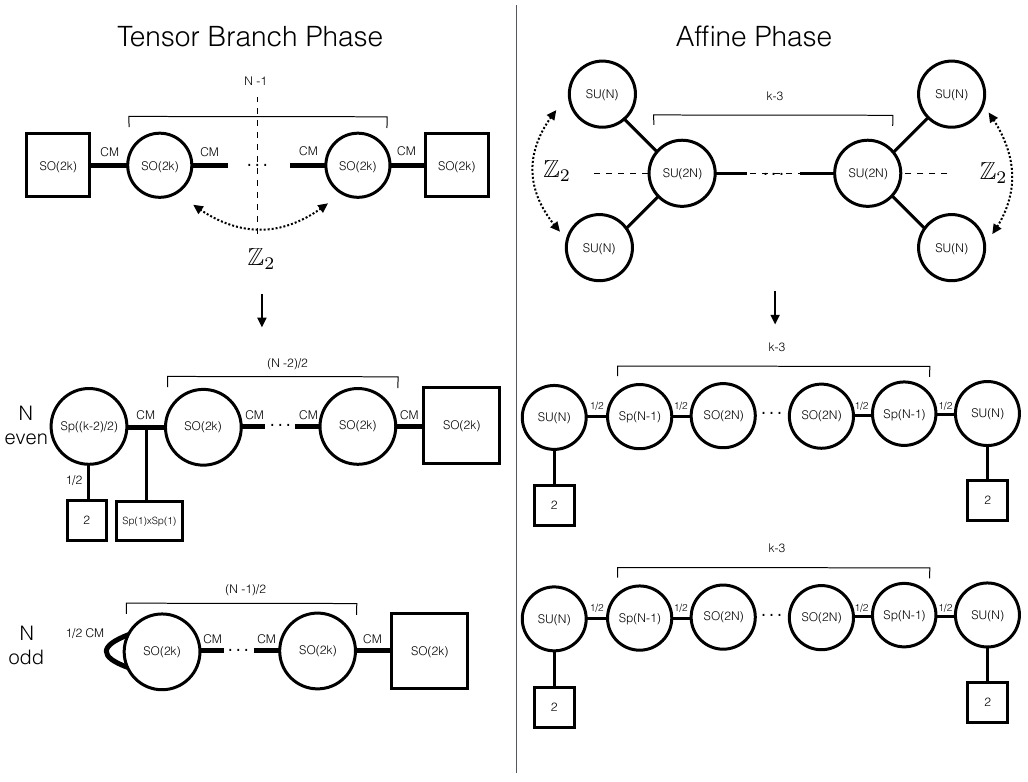
Figure 4 . D-type quiver theories. On top the unquotiented theories in the tensor branch phase (left) and a(cid:14)ne phase (right). On the bottom the two cases depending on N being even or odd for the two corresponding phases. The segments represents standard N = 2 hypermultiplets, when the 1 = 2 appears on a link it stands for half hypermultiplet. The label \CM" means that it is not just an hypermultiplet, but generalized matter coming from compacti(cid:12)cation of the conformal matter given by the two connected gauge